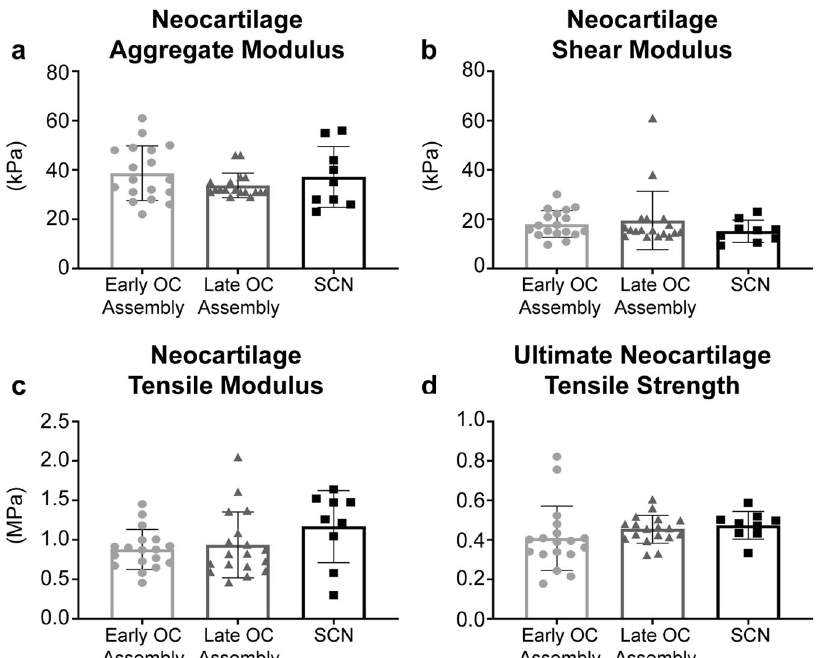
Fig. 5 Neocartilage mechanical properties at the end of 5 weeks of culture. a Aggregate modulus, ( b ) shear modulus, ( c ) tensile modulus, and ( d ) ultimate tensile strength are shown. Data are presented as means with errors bars representing standard deviations. Tensile modulus data were analyzed with a one-way ANOVA with Tukey ’ s post hoc test. Non-parametric Kruskal – Wallis with Dunn ’ s post hoc tests were used to analyze aggregate modulus, shear modulus, and ultimate tensile strength. No statistical differences between groups were detected. OC osteochondral, SCN small control neocartilage.